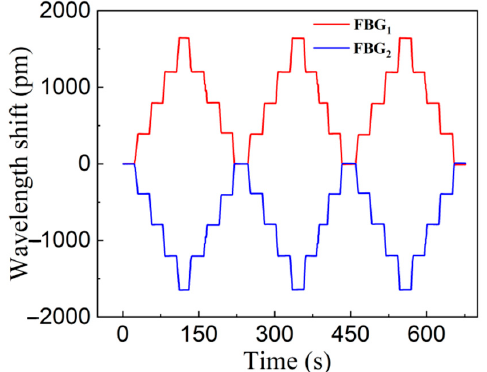
Figure 5. Wavelength shift versus time in three periods of displacement cycle test.